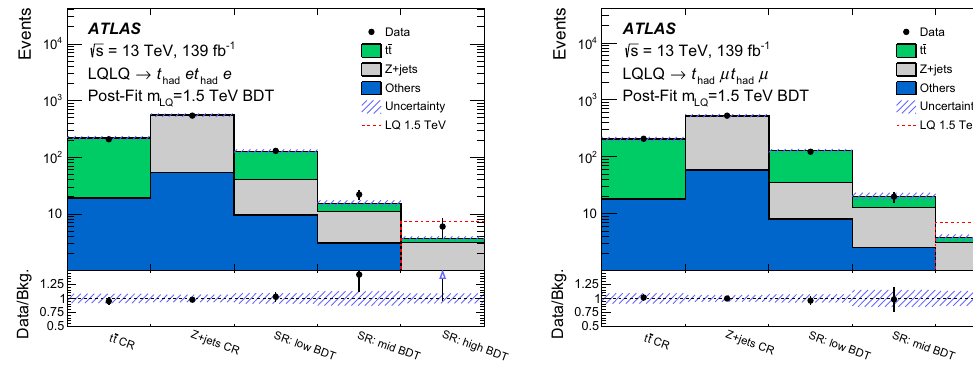
regions. The lower panel shows the ratio of data to the fitted back- ground yields. The band represents the systematic uncertainty after the